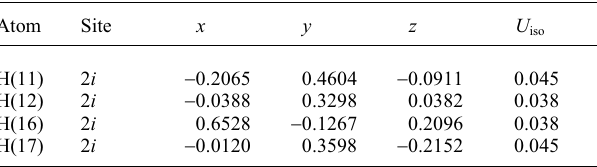
Table 2. Atomic coordinates and displacement parameters (in Å 2 )